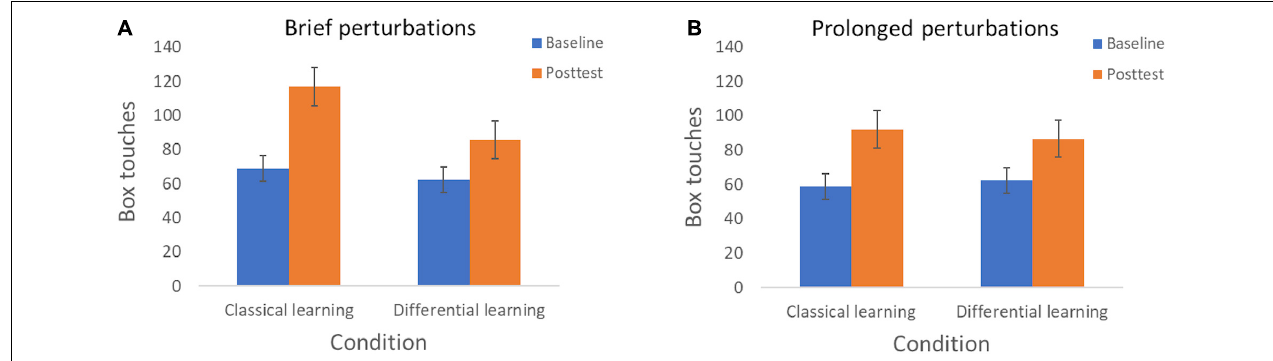
FIGURE 4 | Resilient motor performance—as expressed in box touches—according to Session (Baseline and Posttest) and Training condition (Classical learning and Differential learning). (A) Displays the results when being exposed to brief perturbations (Experiment 1), and (B) displays the results when being exposed to prolonged perturbations (Experiment 2). The error bars correspond to the 95% confidence